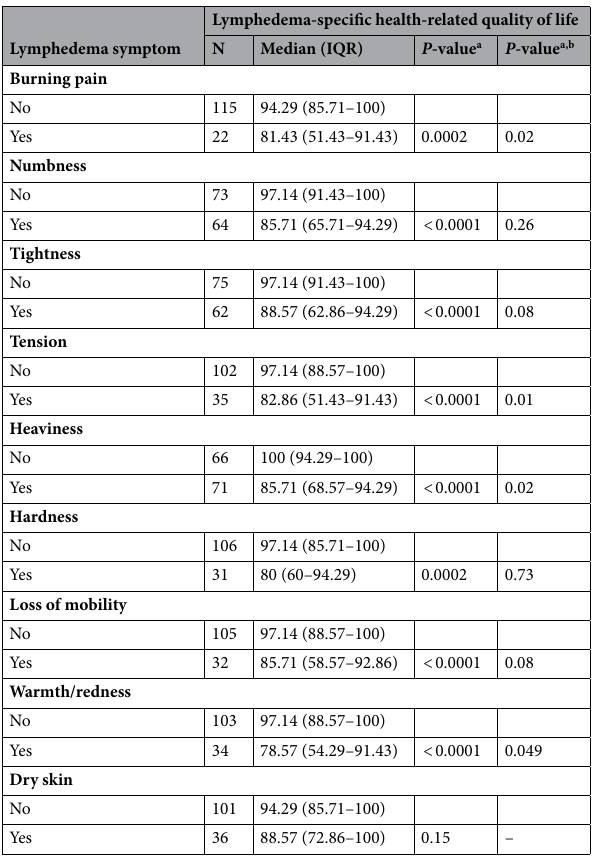
Table 4. Lymphedema symptoms and lymphedema-specific health-related quality of life. IQR interquartile range, N number. a Rank-based analysis of covariance model adjusting for age at 40-month assessment and race/ethnicity was used. b Mutually adjusted for all symptoms excluding dry skin, and additionally adjusted for change in clothing size/style due to